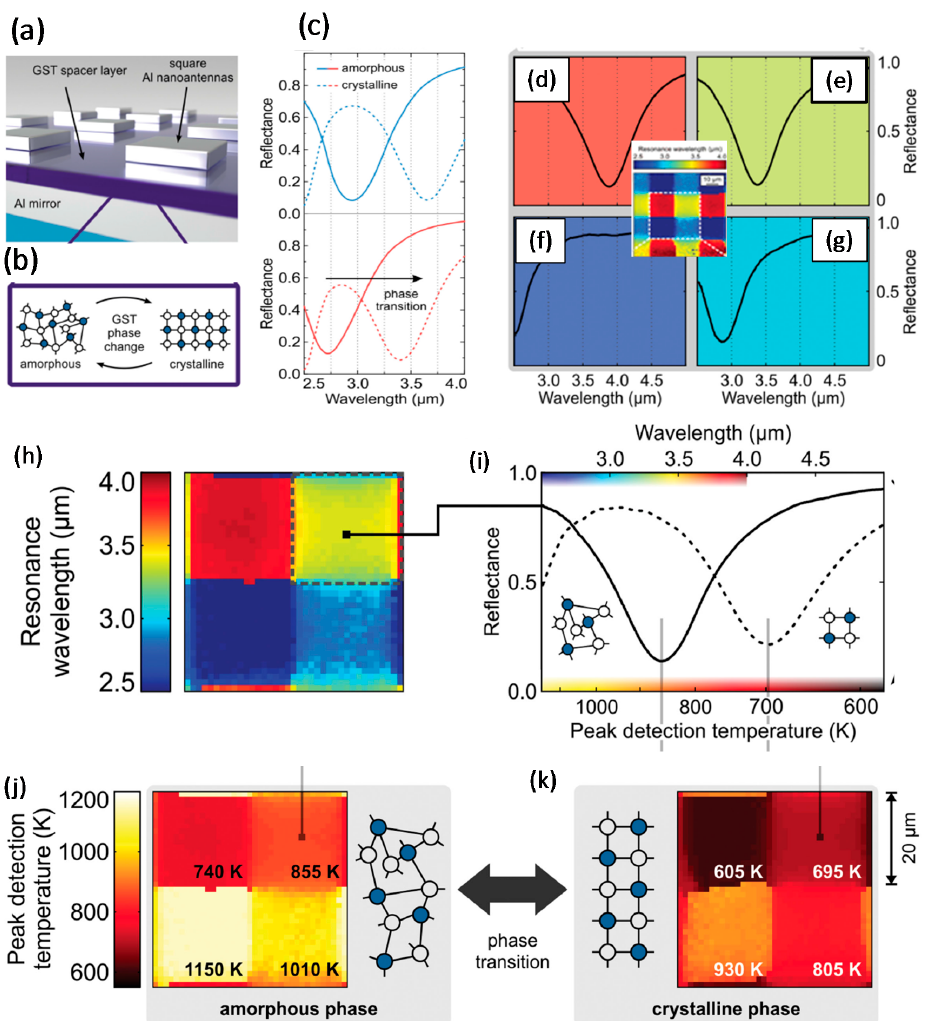
Figure 7. GST-based perfect absorber with image capability. ( a ) Illustration of a switchable absorber; GST is packed between Al nanopatterns and Al mirror; ( b ) Sketch of GST phase change between two amorphous and crystalline phases; ( c ) Reflectance curve in MIR spectral region corresponding to the GST layer in both amorphous and crystalline phases; the higher resonance wavelengths are produced by the larger dimension of antennas; ( d – g ) Typical reflectance spectra of the four specific pixels illustrated in the inset, showing the imaging capability of the perfect absorber; ( h ) The resonance wavelength of four separate MIR absorption ranges; ( i ) Typical reflectance spectra of the yellow color- coded resonance wavelength for GST in both of the amorphous and crystalline phases. Peak detection temperature for the ( j ) amorphous and ( k ) crystalline phass of the GST layer. Adapted from [64],